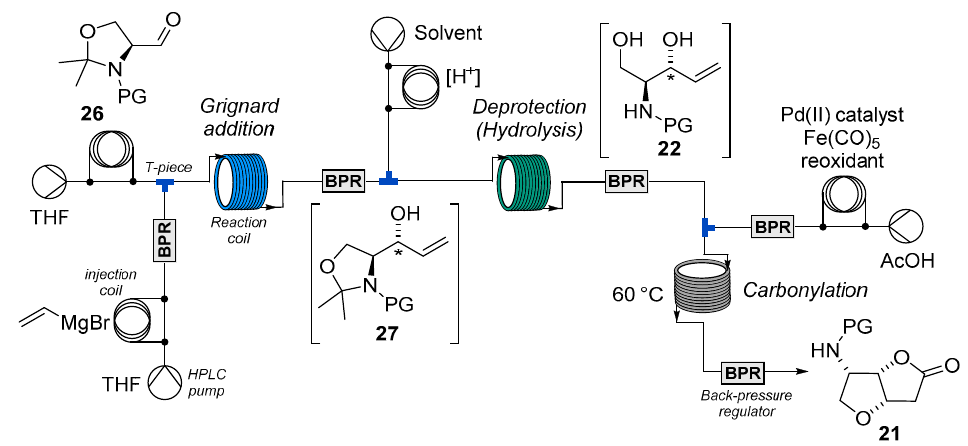
Figure 3. Proposed telescoped flow system for the synthesis of bicyclic lactone 21 .